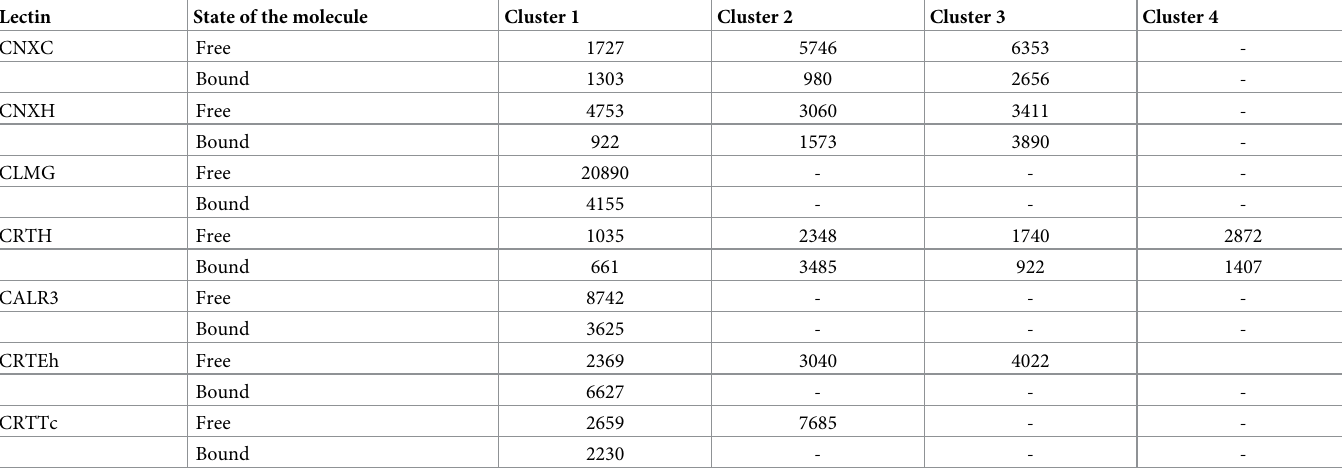
Table 3. Populations size of the metastable conformations of lectins in free and bound state obtained from hierarchical sampling methodology.